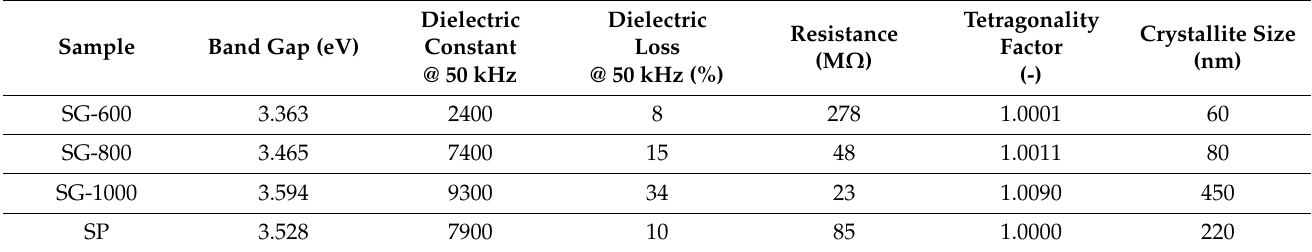
Table 4. Table comparing samples with the respective band gap energy, dielectric properties, tetrago- nality factor and grain size at room